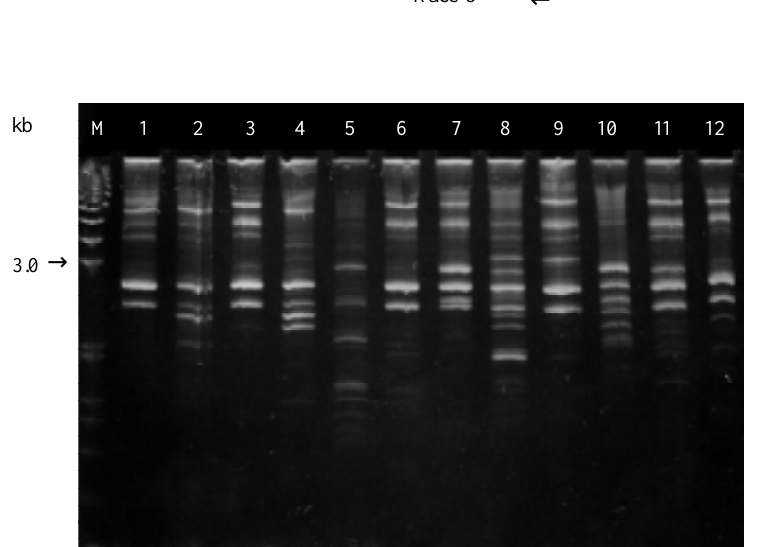
Figure 2 - Electrophoretic analysis of DNA amplification products from Heterodera glycines populations obtained on 8% polyacrylamide gel. Amplifications were performed with primer OPA-07. Lane M = Molecular size standard. Lanes 1 through 16 correspond to the amplification prod- ucts of the 16 SCN populations, as identified in Table